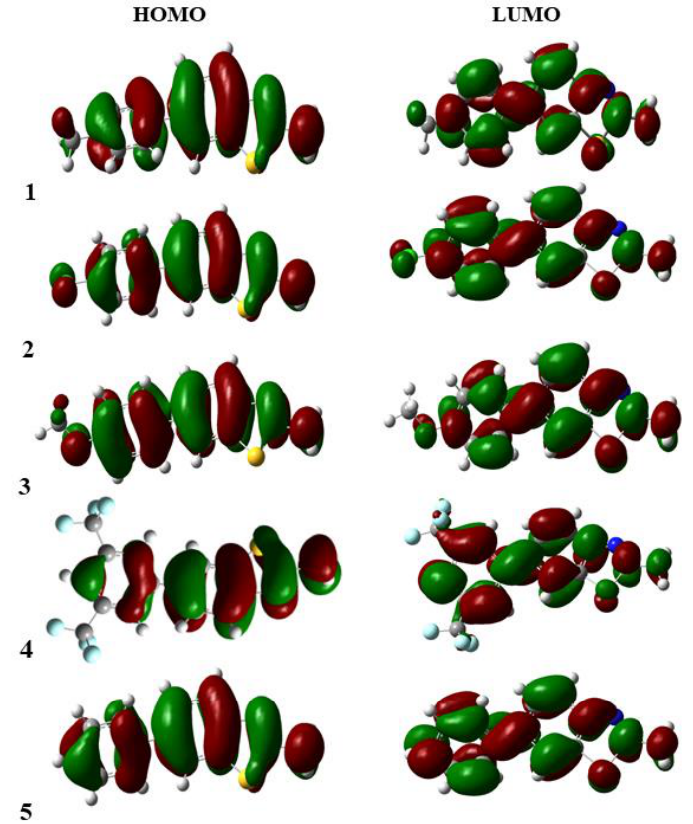
Figure 3. Frontier molecular orbitals of 1 – 5 . Table 2. Energies of HOMO-LUMO, HOMO- LUMO gap (∆E) and hyperpolarizability values. The unit of βo is Hartree.